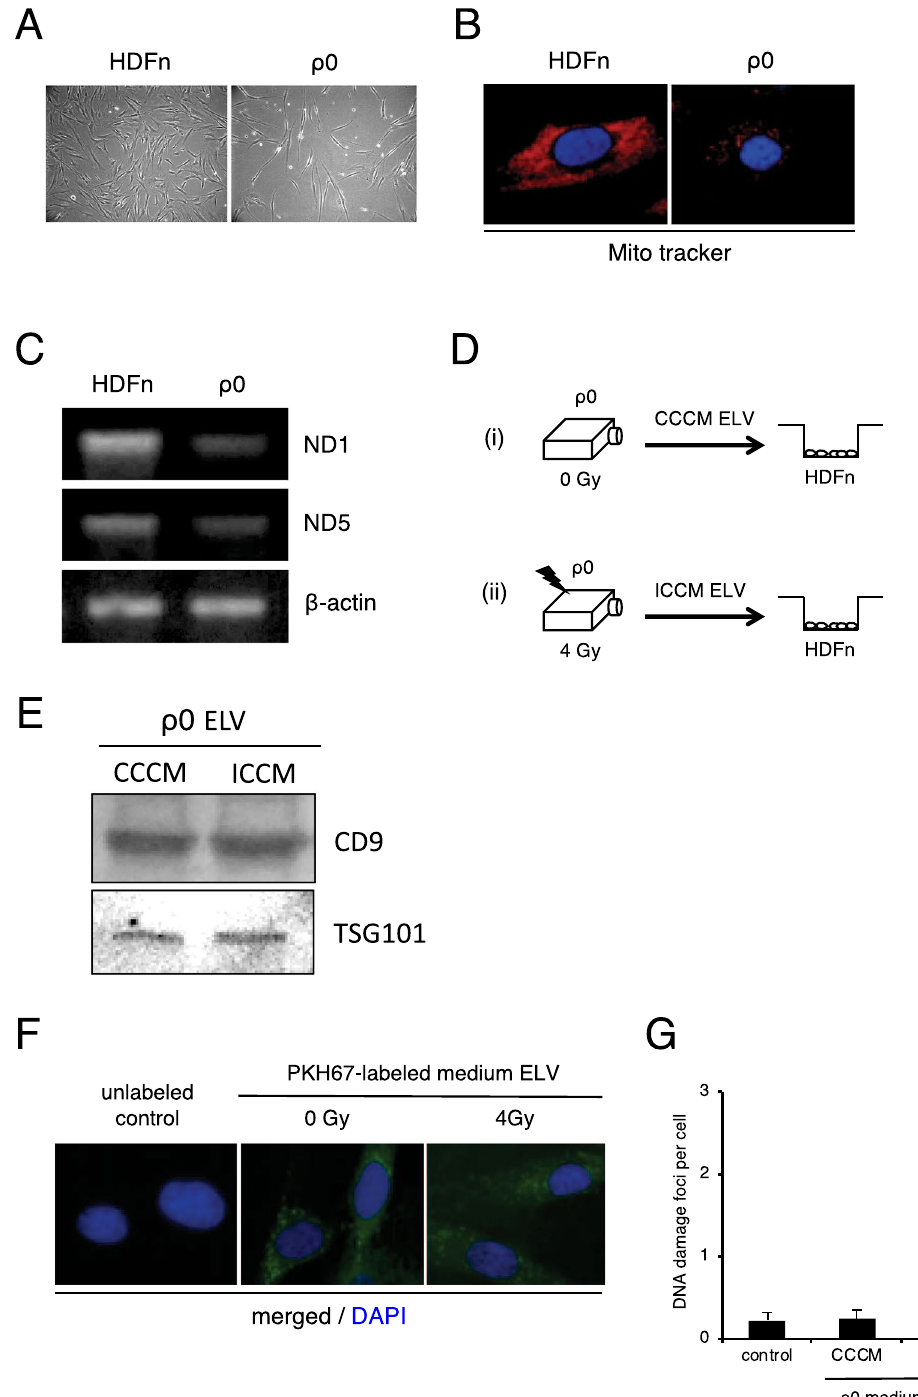
Figure 4. No induction of DNA damage by ELV obtained from mitochondria depleted (rho 0) cells. ( A ) Morphology of rho 0 ( ρ 0) cells and their parental (HDFn) cells. ( B ) Representative image of MitoTracker CMXRos retention (red) in HDFn cells and ρ 0 cells, counterstained with DAPI (blue). ( C ) PCR amplification of mitochondrial ND1 (upper panel) and ND5 (middle panel), internal control beta-actin (lower panel) of HDFn cells and ρ 0 cells. Full images of gels are present in Supplementary Fig. S3. ( D ) A schematic view of the experimental protocol. ( E ) Detection of CD9 and TGS101 proteins in the ELV in medium from control ρ 0 cells and 4 Gy exposed ρ 0 cells. Full-length blots are present in Supplementary Fig. S2. ( F ) Representative image of PKH67 labeled ELV (green) derived from control ρ 0 cells and 4 Gy exposed ρ 0 cells, counterstained with DAPI (blue). ( G ) The frequency of DNA damage foci in un-treated cells (control), cells treated with ρ 0 CCCM ELV and cells treated with ρ 0 ICCM ELV. Values are represented as mean ± standard error, with significant differences between indicated groups ( * ) calculated by Chi-square test ( p <